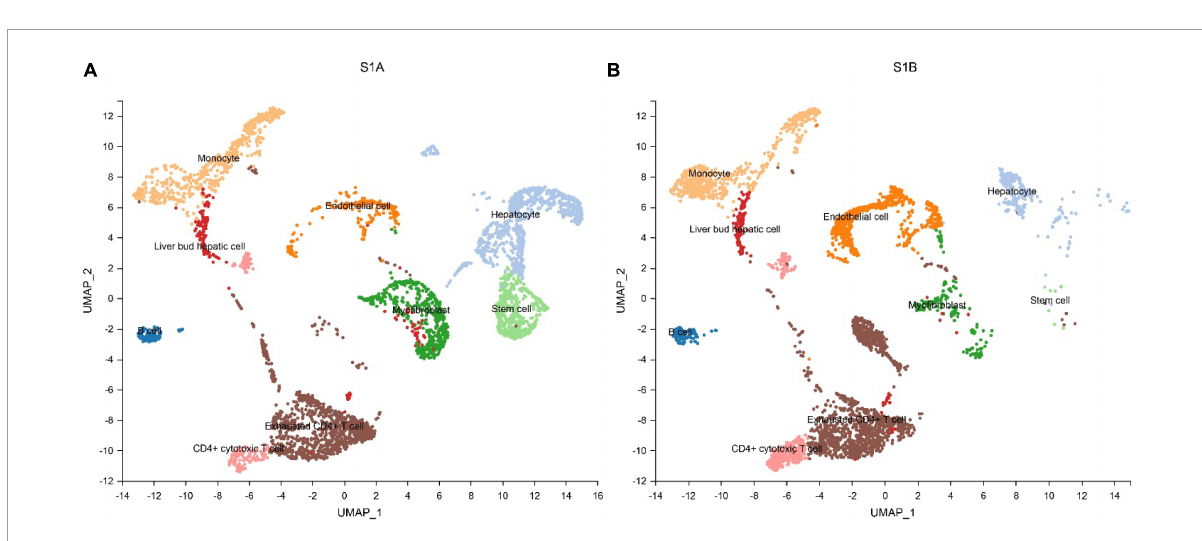
FIGURE6 Cell types identified in tumor tissue (A) and paracancerous liver tissue (B) by uniform manifold approximation and projection